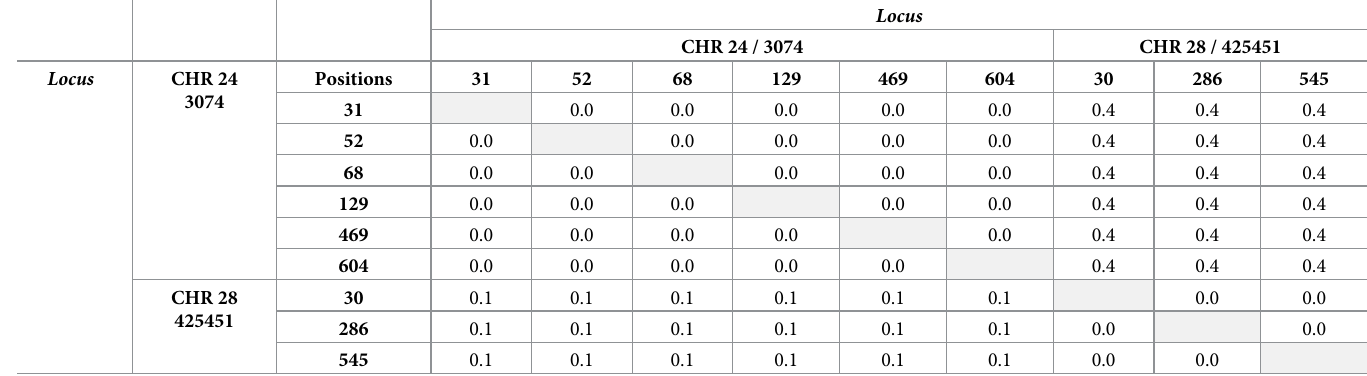
Table 2. Pairwise linkage disequilibrium between SNPs/indels in polymorphic positions of two loci located in chromosomes 24 ( locus CHR24/3074) and 28 ( locus CHR28/425451) of two temporally distinct L . braziliensis populations endemic in Corte de Pedra, Northeast Brazil: 1999–2001 (above gray diagonal), 2008–2011 (below gray